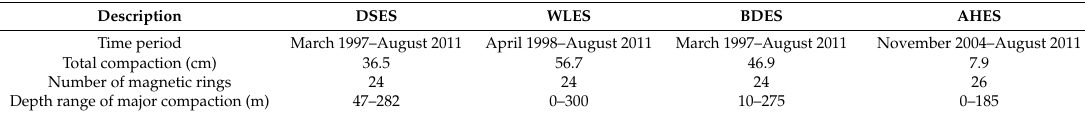
Figure 4. ( a ) Major components of the device used to measure compactions at a multi-layer compaction monitoring well (MLCW); ( b ) A technician operating the device to collect data at a MLCW. Table 1. Information about the four compaction monitoring wells in Chiayi.